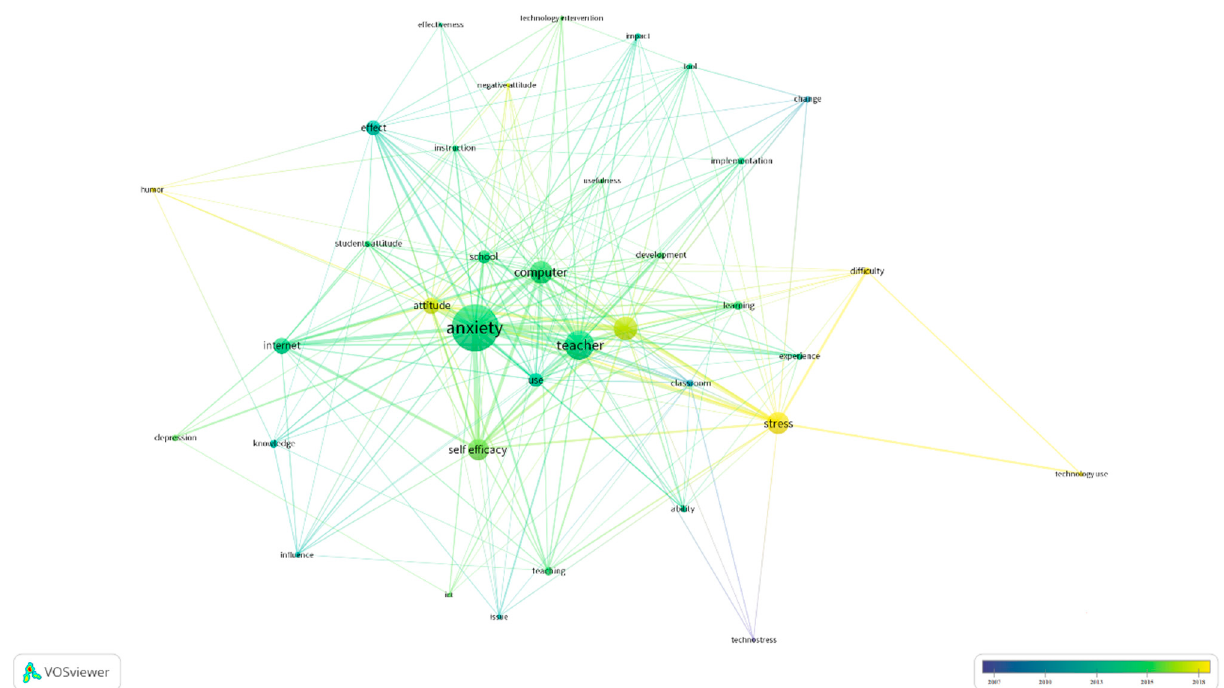
Figure 5. Bibliometric map of the time evolution of the 36 KW+ analyzed.